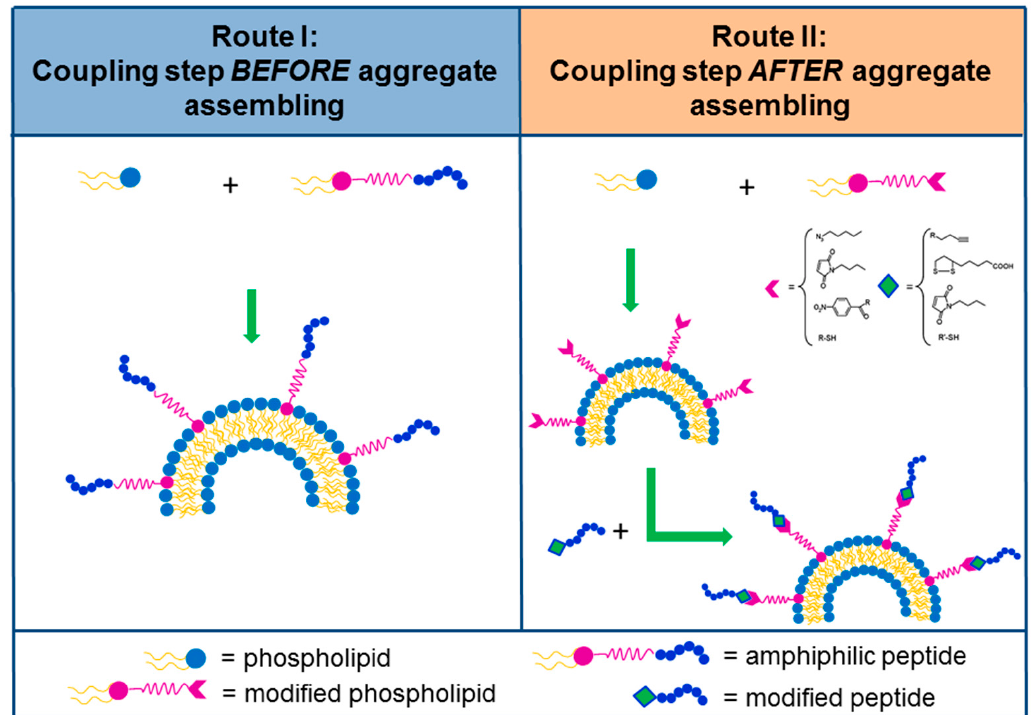
Figure 3. Schematic representation of two approaches used for the synthesis of peptide containing liposomes. In route I (pre-liposomal functionalization) a PA is inserted directly during the liposome formulation. In route II (post-liposomal functionalization) a peptide is anchored on the exteral surfaces after liposome formulation by a selective reaction between two functional groups displayed on the peptide and on the liposome, respectively. Table 1. Supramolecular systems decorated with homing peptides able to selectively recognize integrin receptors or membrane receptors belonging to the GPCR superfamily. The bioactive peptide, the peptide conjugation, the encapsulated API, and the corresponding references are reported. Peptide Derivative Ref.